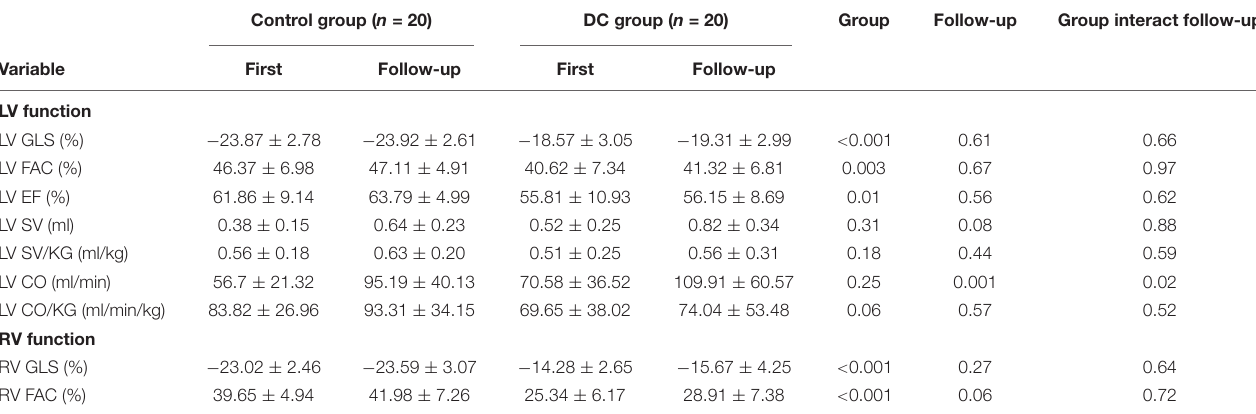
TABLE 8 | Series examinations in DA constriction fetuses for cardiac function analysis by FetalHQ. Control group ( n = 20) DC group ( n = 20) Group Follow-up Group interact